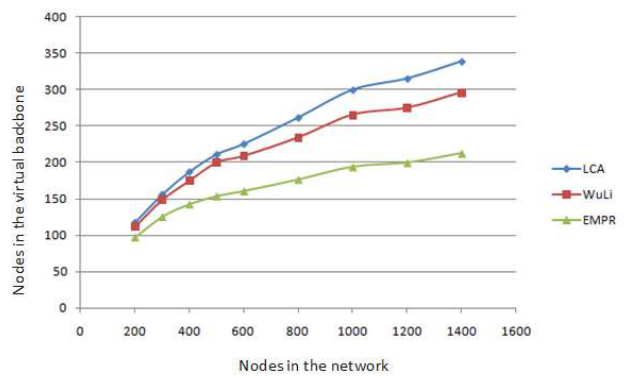
Figure 5. The average number of nodes in the virtual backbone in the random gait